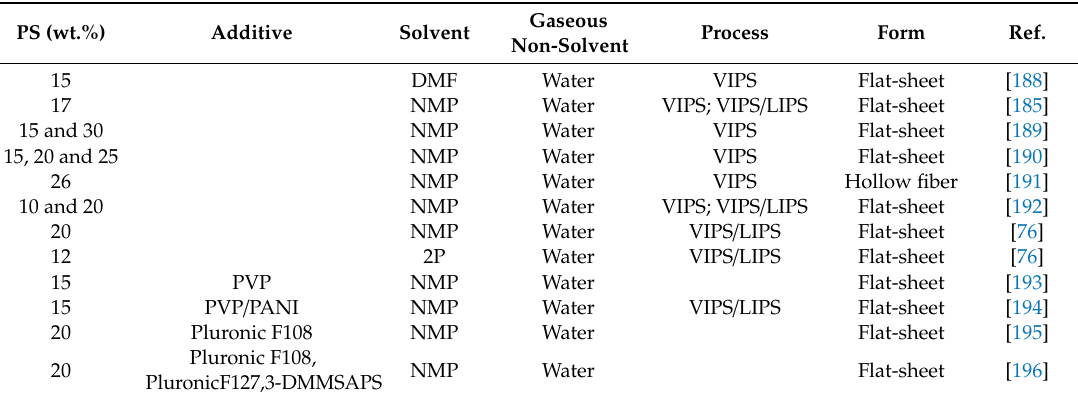
Table 6. Examples of PS membranes produced by